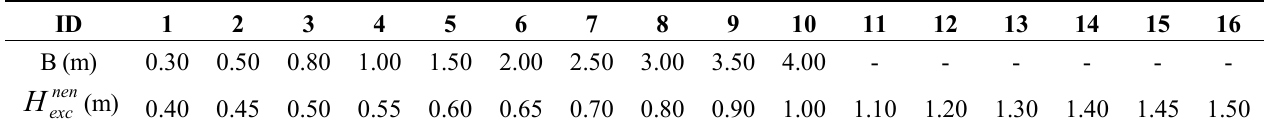
Table 6. Biggiero and Pianese (1996) [64] case study. Bottom width B and network ending H : the node excavation. nen exc